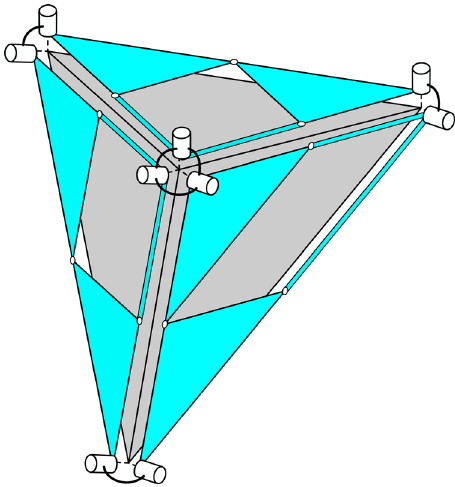
Fig. 4 Connections between pantographs. The relative orientation of adjacent pantograph mechanisms is maintained by compound universal joints. This fi gure shows part of a dilational surface, the triangular faces are shown in gray, and the rigid parts of the pantograph mechanisms are shown in blue. At each of the corners of the pantographs, they are coupled to their neighbors by universal joints. A universal joint consists of two revolute joints (shown as white cylinders) in series. A compound universal joint is created at an intersection with three (or more) triangular